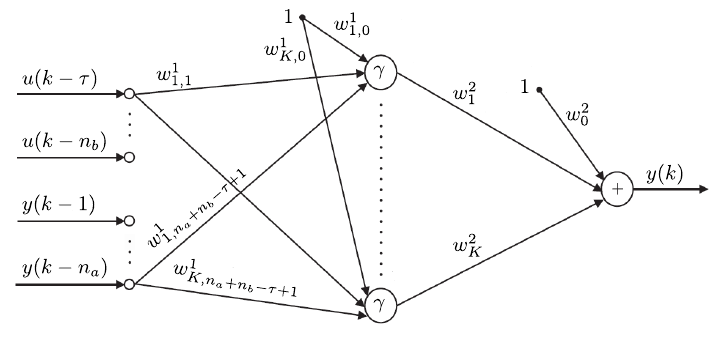
Figure 5. Structure of DLP feedforward